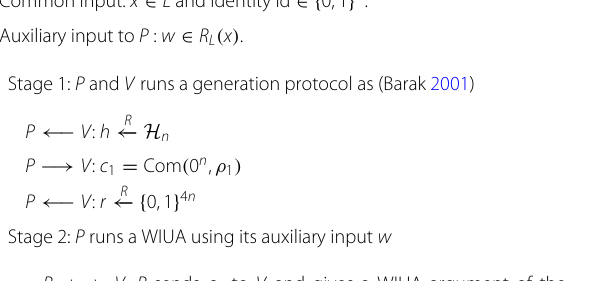
Table 2 Constant-round concurrent non-malleable zero-knowledge